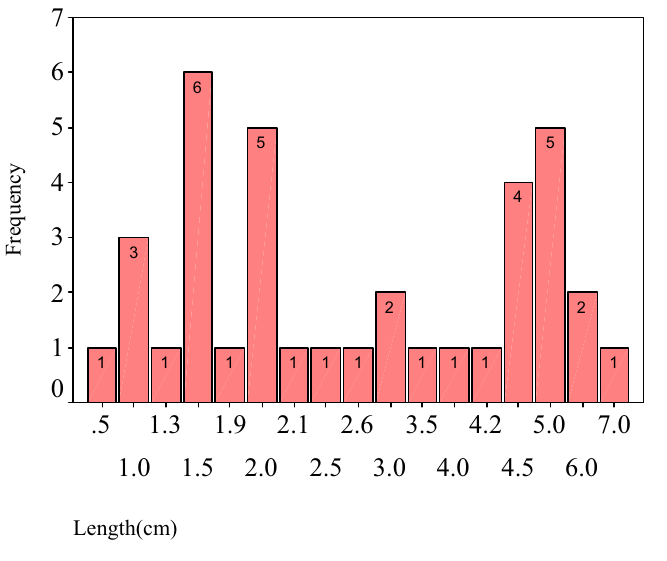
FIGURE 1 - Pedicle length of SIEA (n=37)